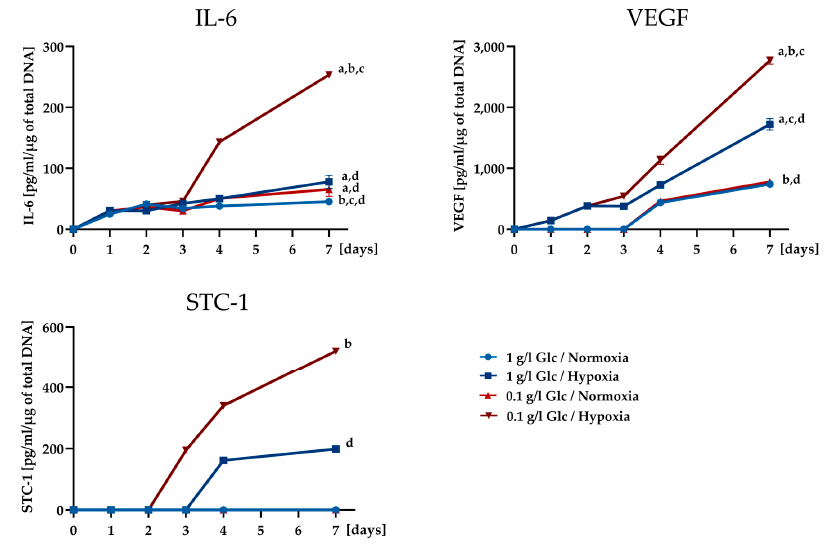
Figure 6. Time course of secretion of IL-6, VEGF, and STC-1 monitored over seven days under different deprivation conditions and quantified by ELISA; the obtained values were normalized to the DNA content of the respective samples. Data are presented as means ± SD of n = 3; (a) significantly different to the value of group 1 g/L glucose and normoxia at day 7, (b) significantly different to the value of group 1 g/L glucose and hypoxia at day 7, (c) significantly different to the value of group 0.1 g/L glucose and normoxia at day 7, (d) significantly different to the value of group 0.1 g/L glucose and hypoxia at day 7; * p < 0.05; for clarity, significance is only shown for day 7. Abbreviations: IL-6: Interleukin-6; VEGF: Vascular endothelial growth factor; STC-1: Stanniocalcin-1; ELISA: Enzyme- linked immunosorbent assay.